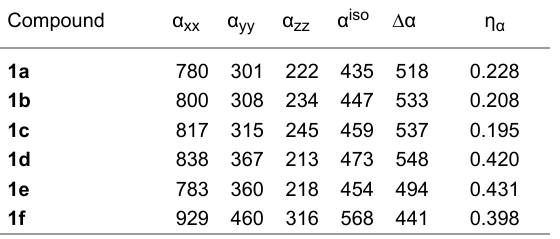
Table 3: DFT calculated principal polarizability components ( α xx , α yy , α zz ), isotropic polarizability α iso = ( α xx + α yy + α zz )/3,